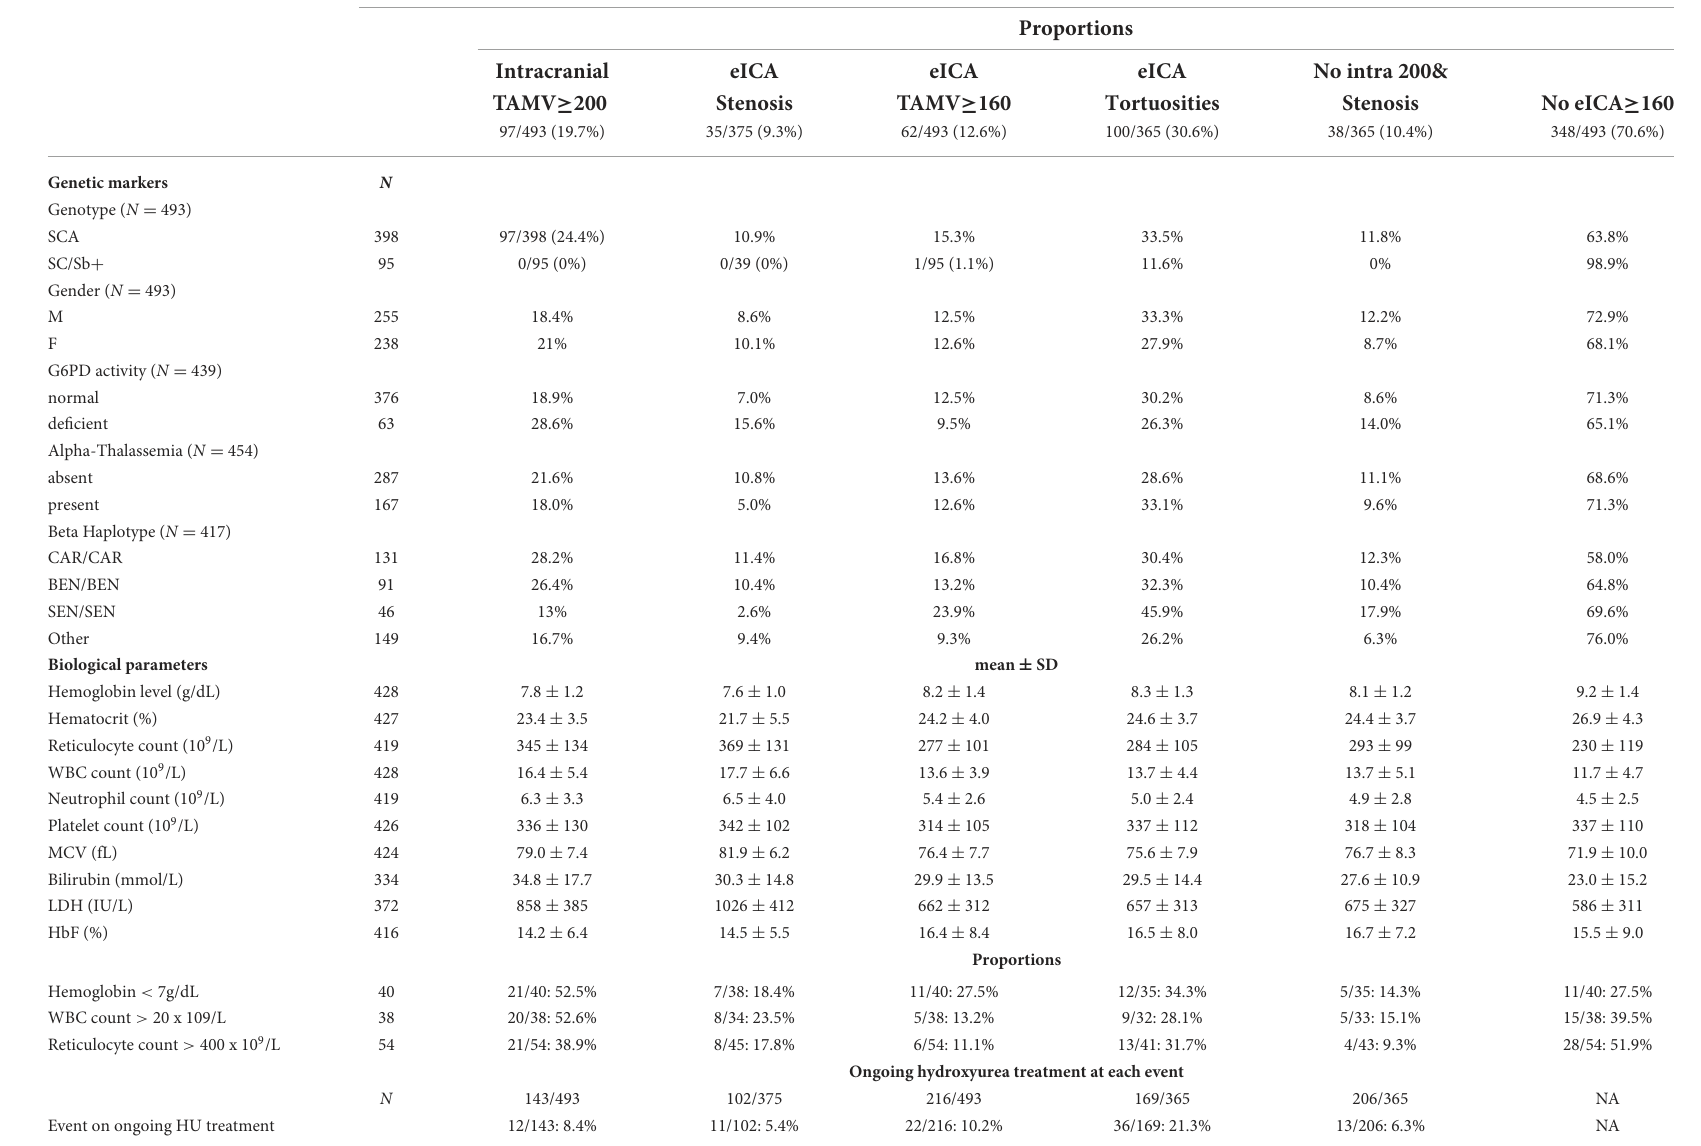
Overall SCD population: SCA and SC/Sb + ( N = 493)